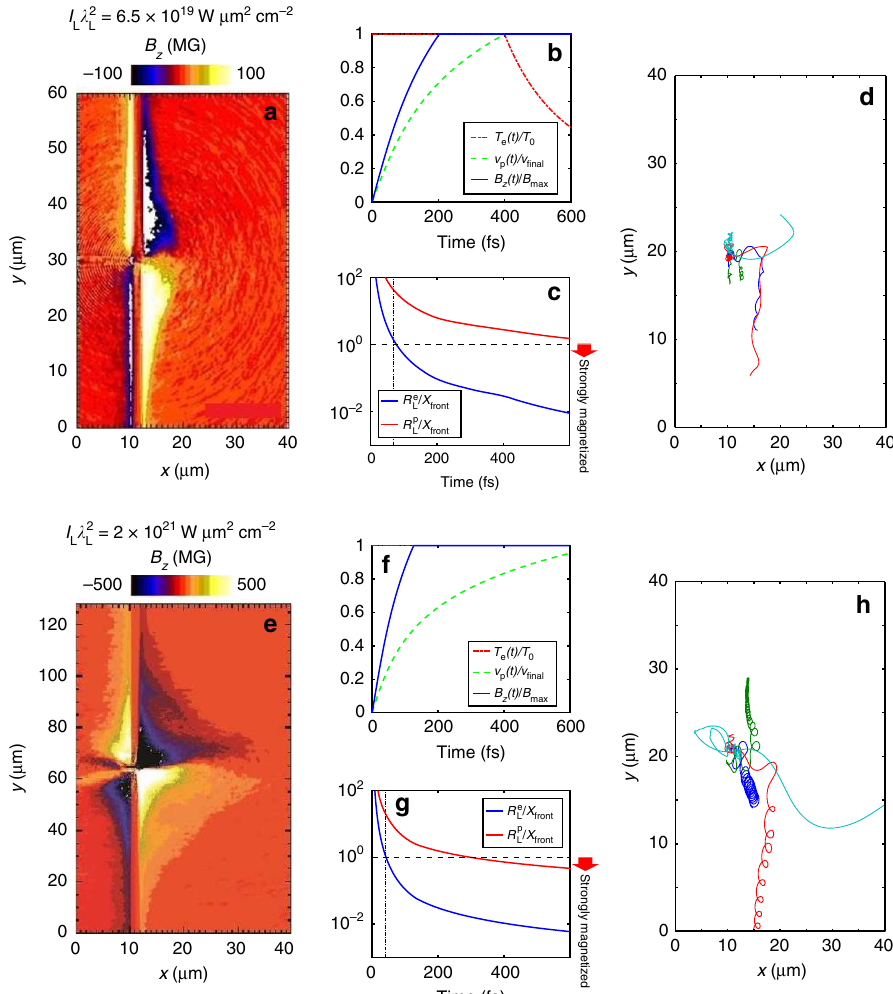
Fig. 1 Laser-driven magnetic- fi eld generation and resulting particle dynamics. a , d , e , h 2D particle-in-cell (PIC) simulation results obtained using the ( a , e ) PICLS 26 and ( d , h ) PICADOR 59 codes (see Methods). The laser pulse impinges from the left onto a 2- μ m thick Al foil, coated on its rear side (located at x = 12 μ m) with a 20-nm thick proton layer. The laser FWHM spot size ϕ τ λ I λ 2 are, respectively, ( a , d ) 1 μ m, 400 fs, L , duration L , wavelength L and intensity L L 0.5 μ m, 6.5 × 10 19 W μ m 2 cm − 2 and ( e , h ) 1.6 μ m, 700 fs, 1 μ m and 2 × 10 21 W μ m 2 cm − 2 . a , e Magnetostatic fi eld B z (in MG) developing inside and outside the target at 100 fs after the laser peak. d , h Sample electron trajectories from the PIC simulations, exiting the target at the laser peak. In d , the electron energies lie in the same range: 13.8 MeV (green), 14.3 MeV (red), 12.3 MeV (blue) and 18.7 MeV (cyan), yet the green electron proves more strongly magnetized because it is ejected into the vacuum about 50 fs later, and thus experiences a higher B - fi eld. In h , the electron energies are 25.2 MeV (blue), 27.7 MeV (green), 90.9 MeV (red) and 162.7MeV (cyan). b , c , f , g Results from the 1D expansion model (see Methods) at a laser intensity of ( b , c ) I λ 2 ¼ 6 : 5 ´ 10 19 W μ m 2 cm (cid:1) 2 and ( f , g ) I λ 2 ¼ 2 ´ 10 21 W μ m 2 cm (cid:1) 2 using the corresponding PIC simulation parameters. b , f Time evolutions of the proton L L L L velocity, ν p ( t ), normalized to its fi nal value (dashed green line), of the electron temperature, T e ( t ), normalized to its initial value ( T 0 = 1.1 MeV in b and T 0 = (cid:1) (cid:3) 1 = 2 5.6 MeV in f , see Methods) (dashed-dotted red line), and of the inductive B - fi eld, normalized to its predicted saturation value B max (cid:6) 2 μ 0 n h ; rear k B T 0 ( B max = 144 MG in b and B max = 537 MG in f ) (solid blue line). c , g Time evolutions of the electron ( R e , blue) and proton ( R p , red) radii, normalized to L L the instantaneous longitudinal extent of the proton plasma, x front ( t ). The horizontal dashed black line delimitates the boundary between the regimes of = x < 1) and weak ( R e ; p = x > 1) magnetization. The vertical dashed-dotted line indicates the time when the ion front has moved a strong ( R e ; p front front L L